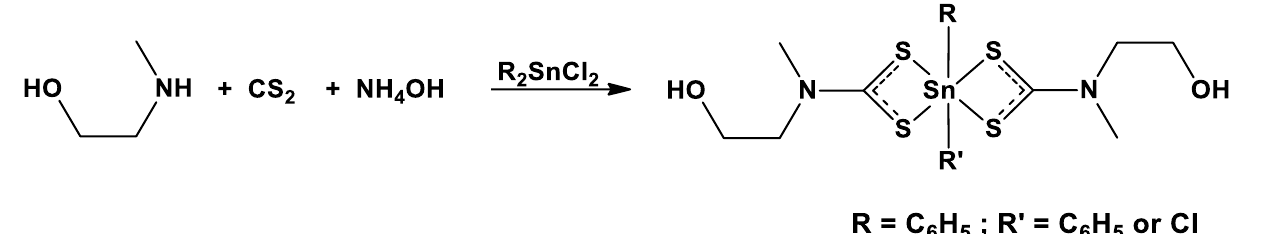
Scheme 1. Synthetic scheme of the phenyltin(IV) N- methyl -N- hydroxyethyldithiocarbamate com-